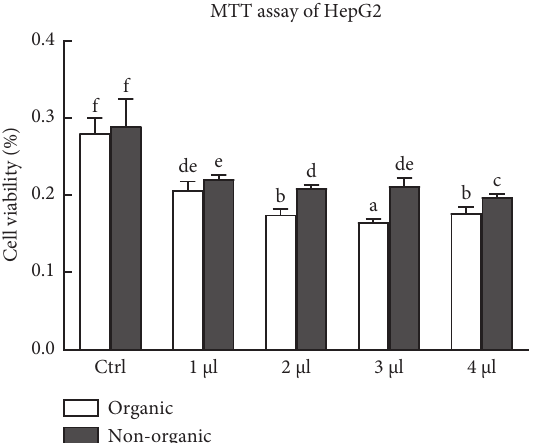
Figure 6: Anticancer activity of both organic and nonorganic vegetable soups using HepG2 cell lines. Ctrl represents control, i.e., 0 µ L of soup. Each data point is the mean of triplicated data with ± SE. The bars represented with different letters are significantly different from each other at p � 0 . 05 as evaluated by